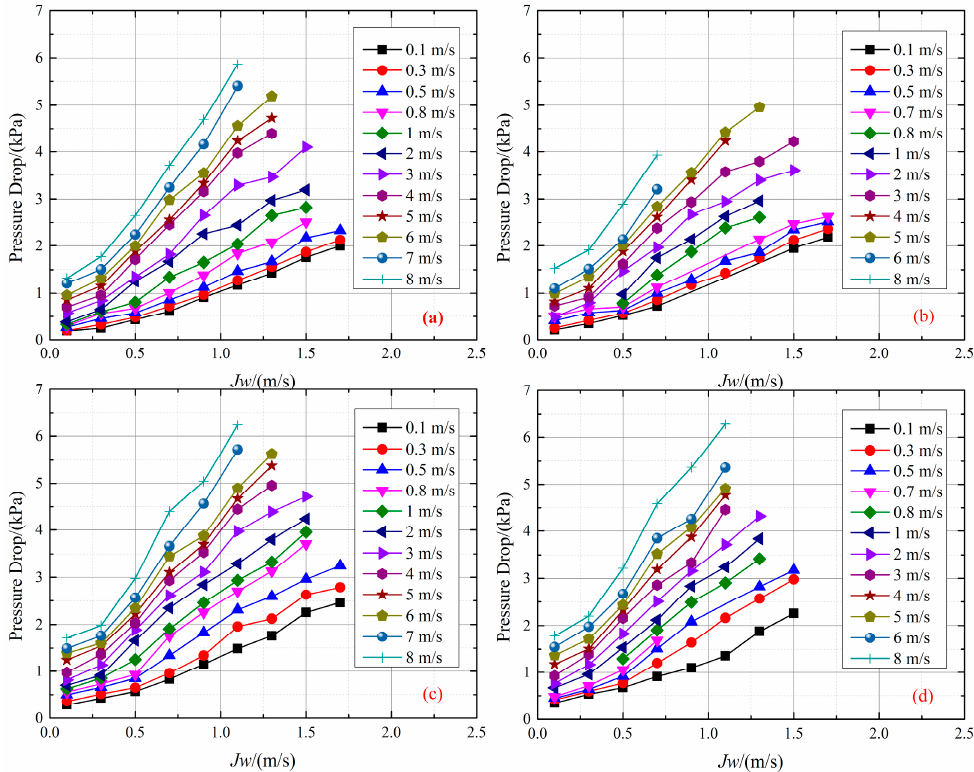
Figure 8. The effect of flow velocity on the Δ P f ( H = 0.8 Hz): ( a ) A = 62 mm, ( b ) A = 80 mm, ( c ) A = 106 mm, ( d ) A = 120 mm.